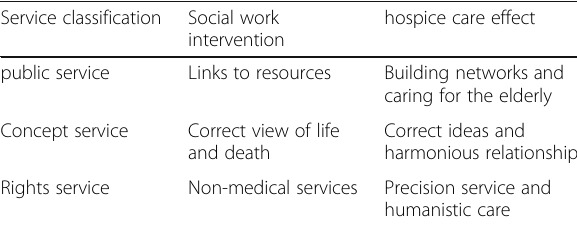
Table 1 Functional system table of social work intervention in elderly patients with hospice